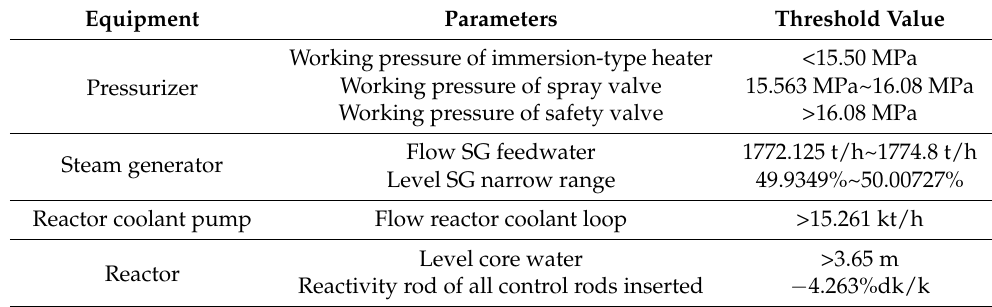
Table 11. Threshold of different parameters.